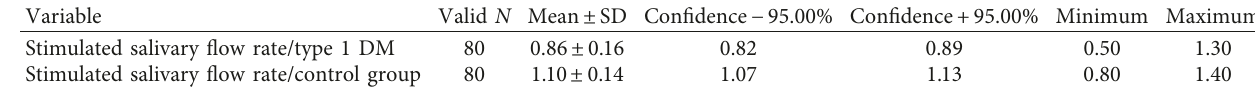
Table 3: The average and standard deviation of salivary flow rate.